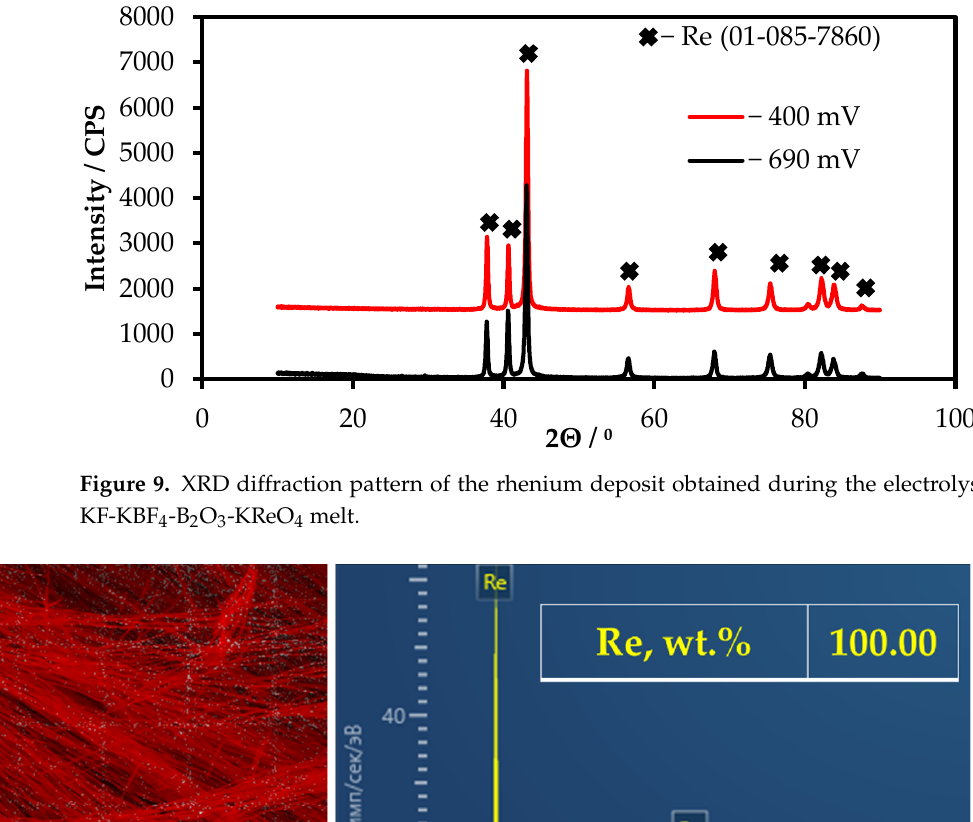
potentials of 690 mV ( B ).